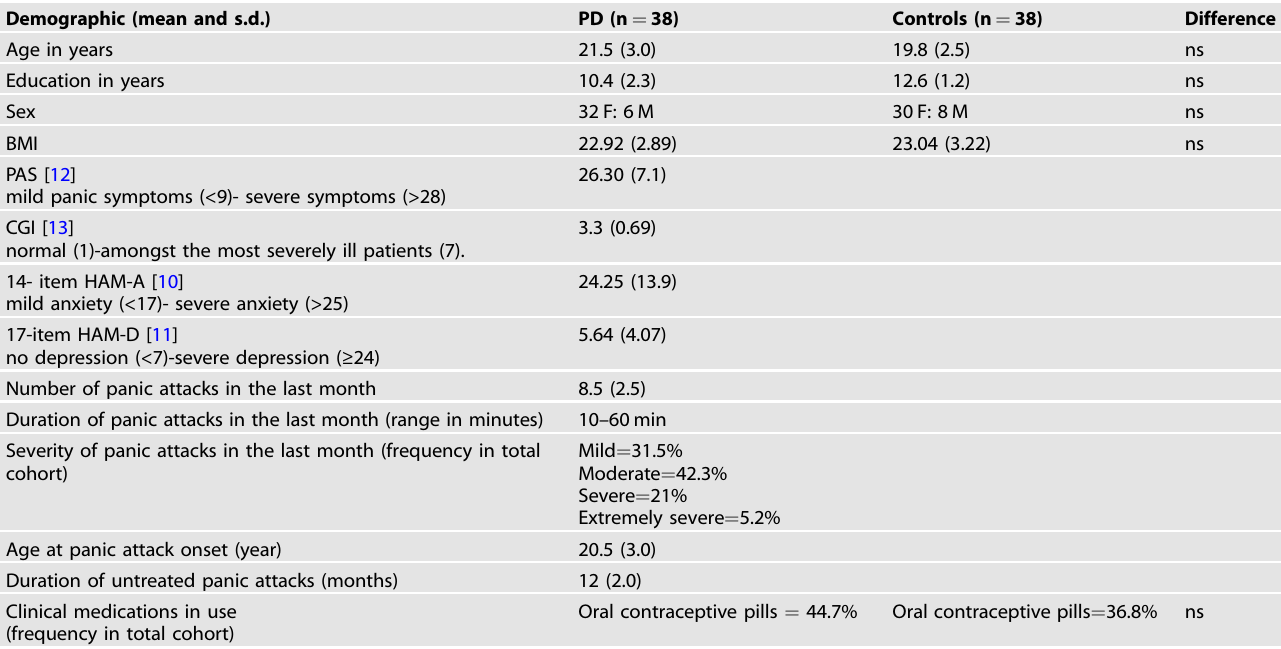
Table 1. Demographics of study